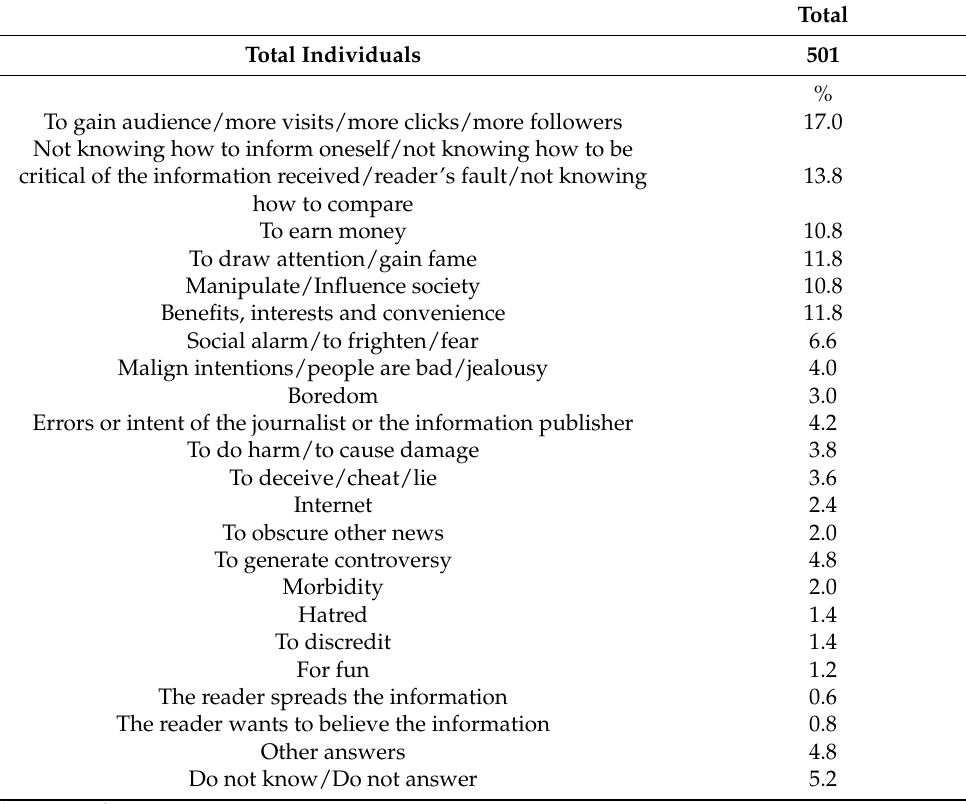
Table 9. Question 4: When you read a news item, either because you looked for it on the Internet or it was sent to you through any medium, such as WhatsApp, Instagram, Tik Tok, email, etc., how well do you think you know how to identify whether it is fake news, a rumor, a hoax, a lie?